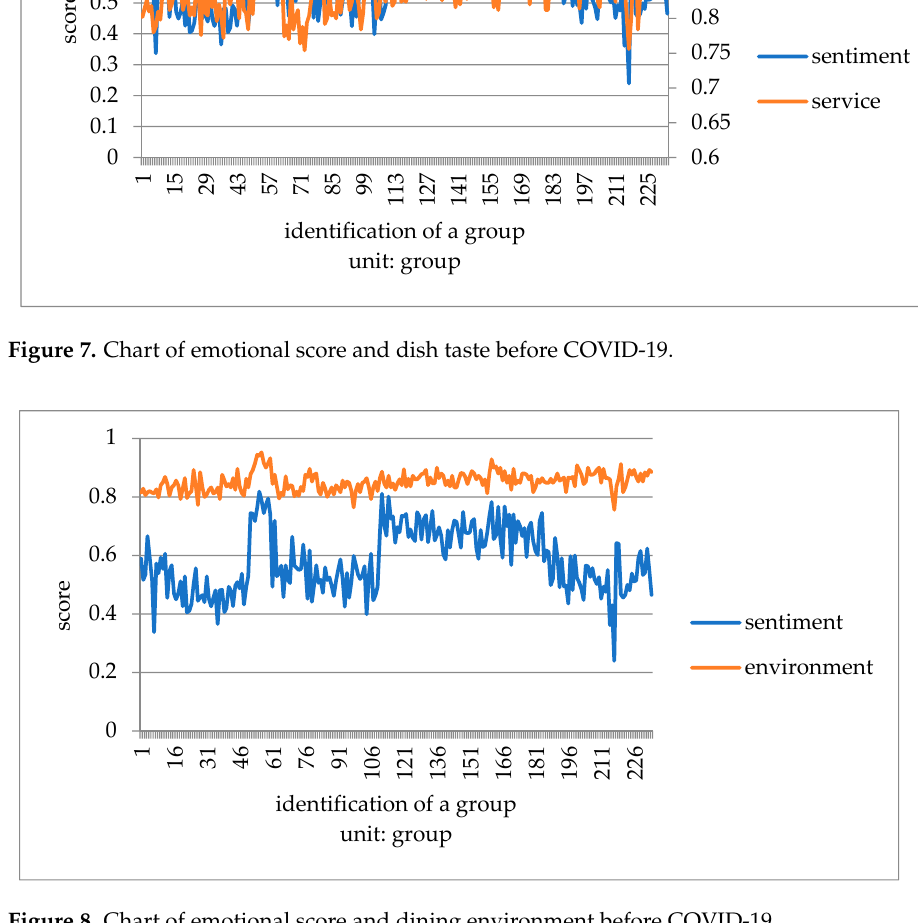
Figure 8. Chart of emotional score and dining environment before COVID-19.